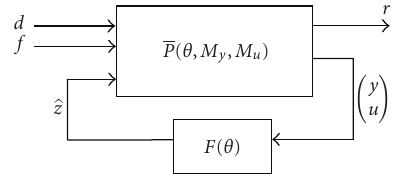
Figure 3: FDI/LPV filter design